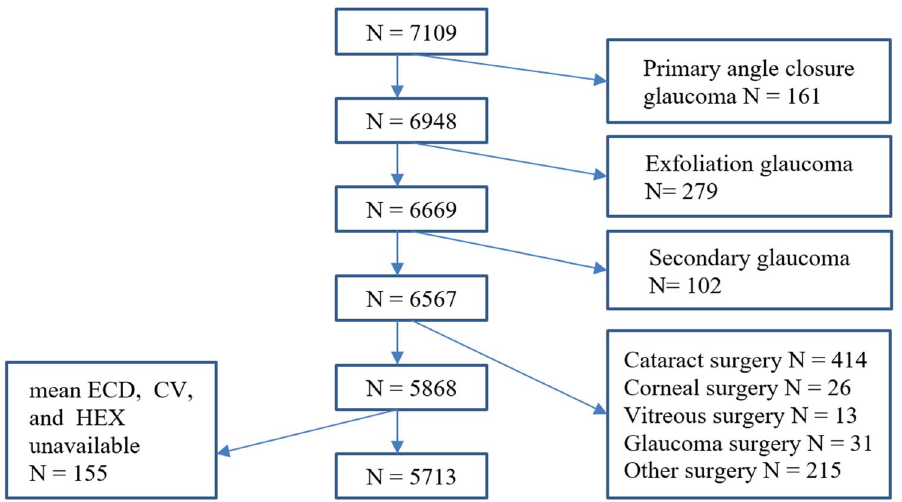
Figure 1. Flow chart of the study participants. Among 7109 participants, 542 eyes with histories of primary angle closure glaucoma, exfoliation glaucoma, and secondary glaucoma, and 699 eyes with ocular surgical histories were excluded. A total 155 eyes with unavailable mean endothelial cell density, coefficient of variation, and hexagonality data were also excluded from the analysis. ECD endothelial cell density, CV coefficient of variation, HEX